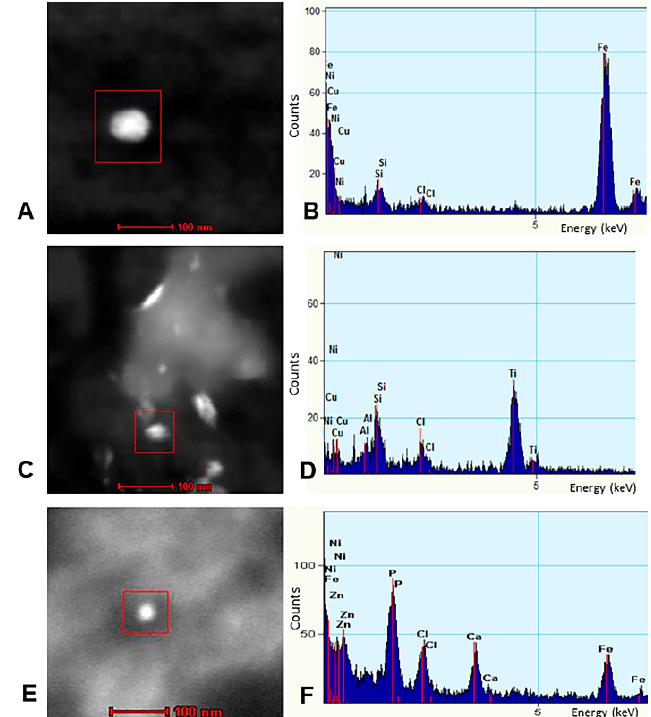
Figure 6. NP characterization by TEM and EDX in human granular cell layer, cerebellum. ( A ) One spherical NP is enclosed by a red square. ( B ) EDX identifies Fe as the main element in the NP. ( C , D ) Typical crystal morphologies and fused surface textures of CFDNPs are co-associated with other reactive metals including Ti and Al. ( E , F ) A CFDNP particle displays Fe and Zn. Ni traces reflect the Ni TEM support grid.